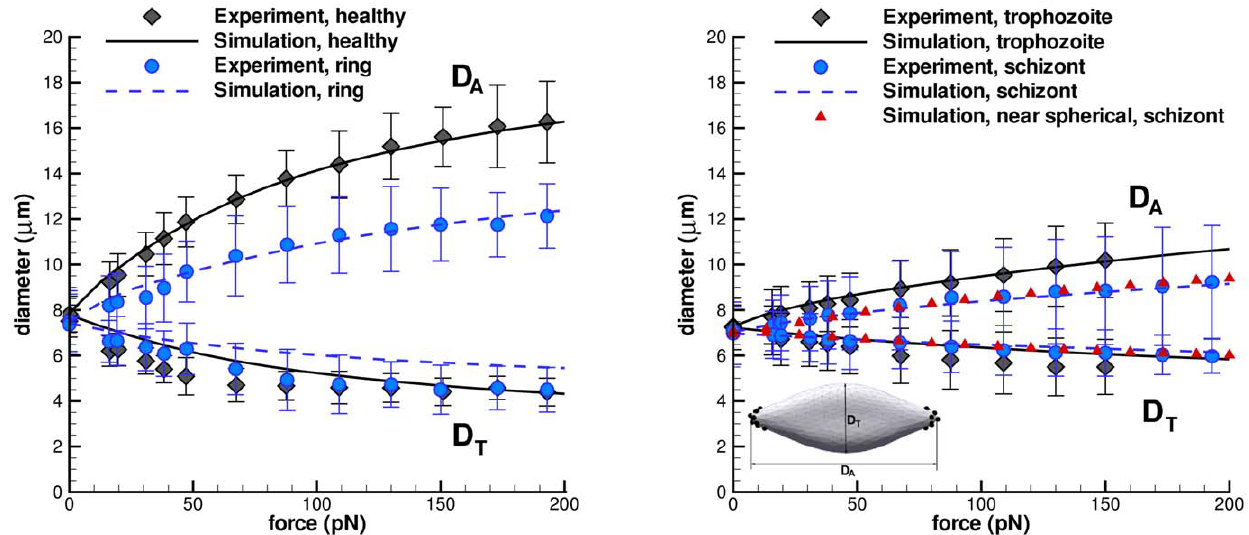
Figure 1. Stretching response of healthy RBCs and Pf-RBCs for different stages compared with the experiments in [ 3 ] at T ~ 23 o C . D A and D T are the axial and transverse RBC diameters, respectively, as shown in the inset plot. The shear moduli of Pf-RBCs for different stages are given in Table 1. The bending stiffness and the membrane viscosity in all cases are set to 2 : 4 | 10 { 19 J and 0 : 022 Pa : s , respectively.